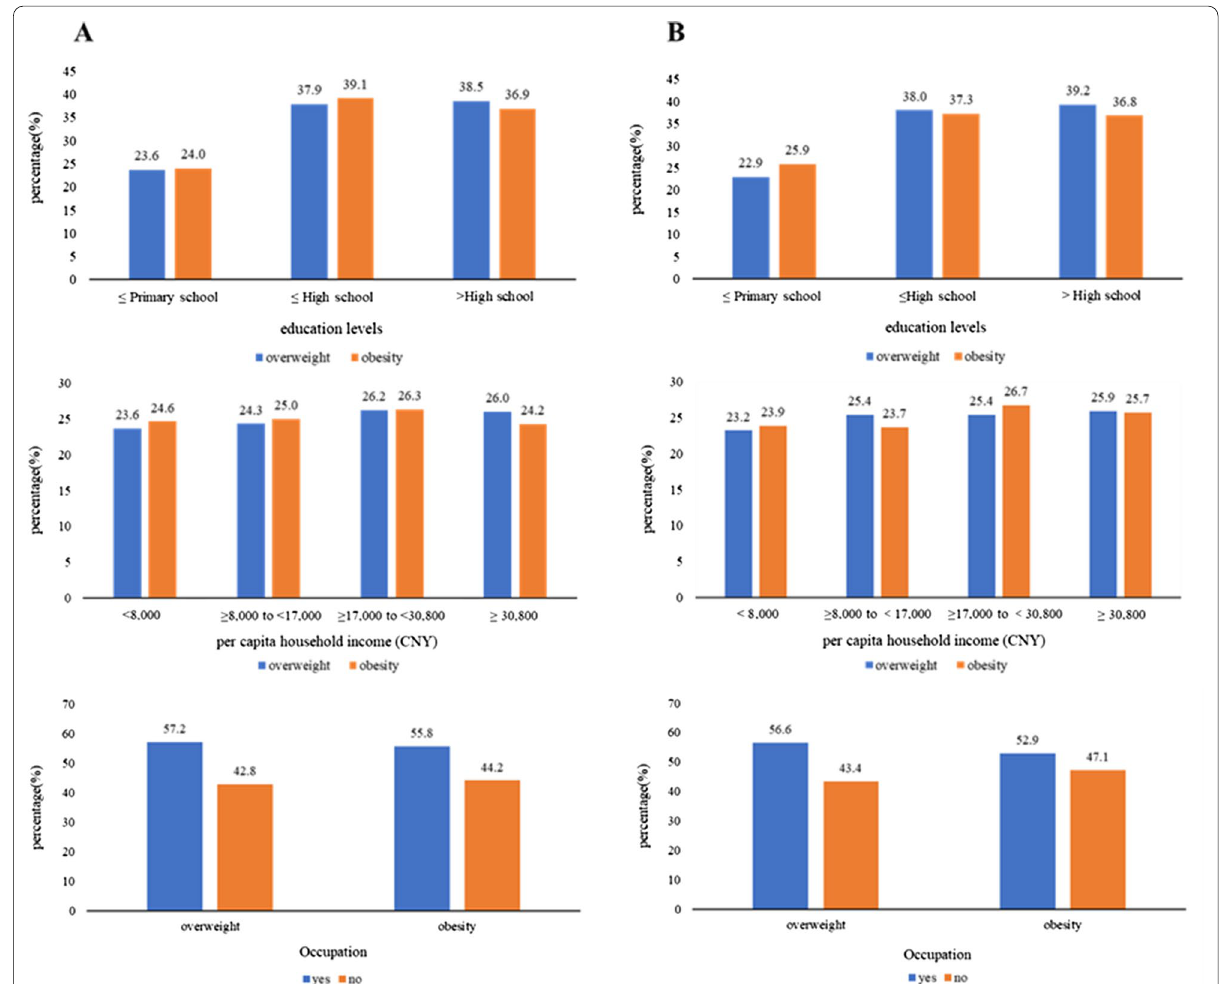
Fig. 1 Percentages of overweight and obesity with different education levels, income groups, occupation status (A: BMI, B: WC). Note : BMI is defined as weight (kg) divided by the square of height (m) (kg/m 2 ), WC (in cm) wasmeasured with a tape measure at the mid-point between the lower edge of the rib cage and the iliac